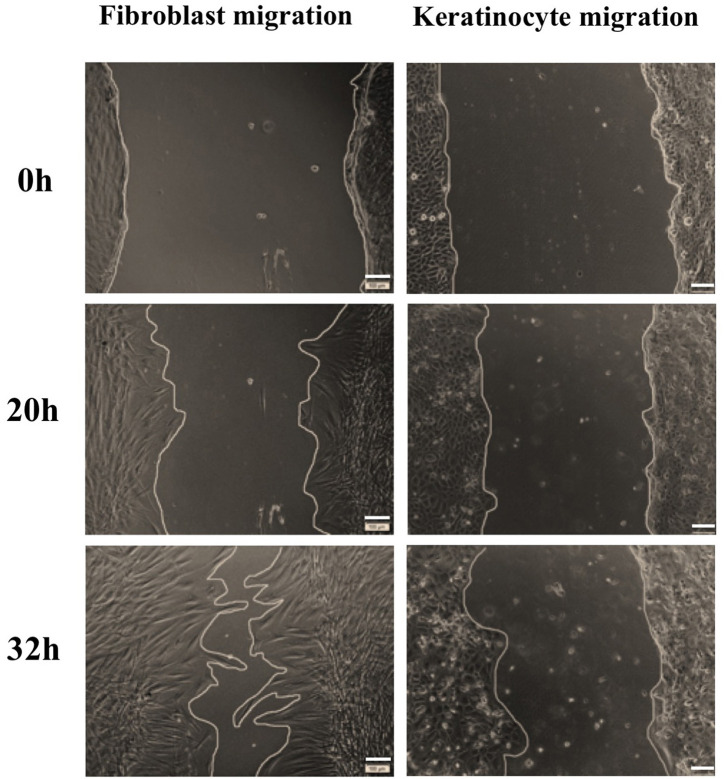
Representative images of fibroblast and keratinocyte migration under stimulation of BMMSC-derived exosomes within the dose of 20 μg exosomal protein. The primary fibroblasts and keratinocytes were seeded with 2 × 105 and 3 × 105 cells/well, respectively, and inhibited cell proliferation using mitomycin C. A wound scratch was created for each well and cells were imaged at different time points. In comparison to keratinocytes, fibroblasts migrated faster to close the wound. Scale bars indicate 100 μm.